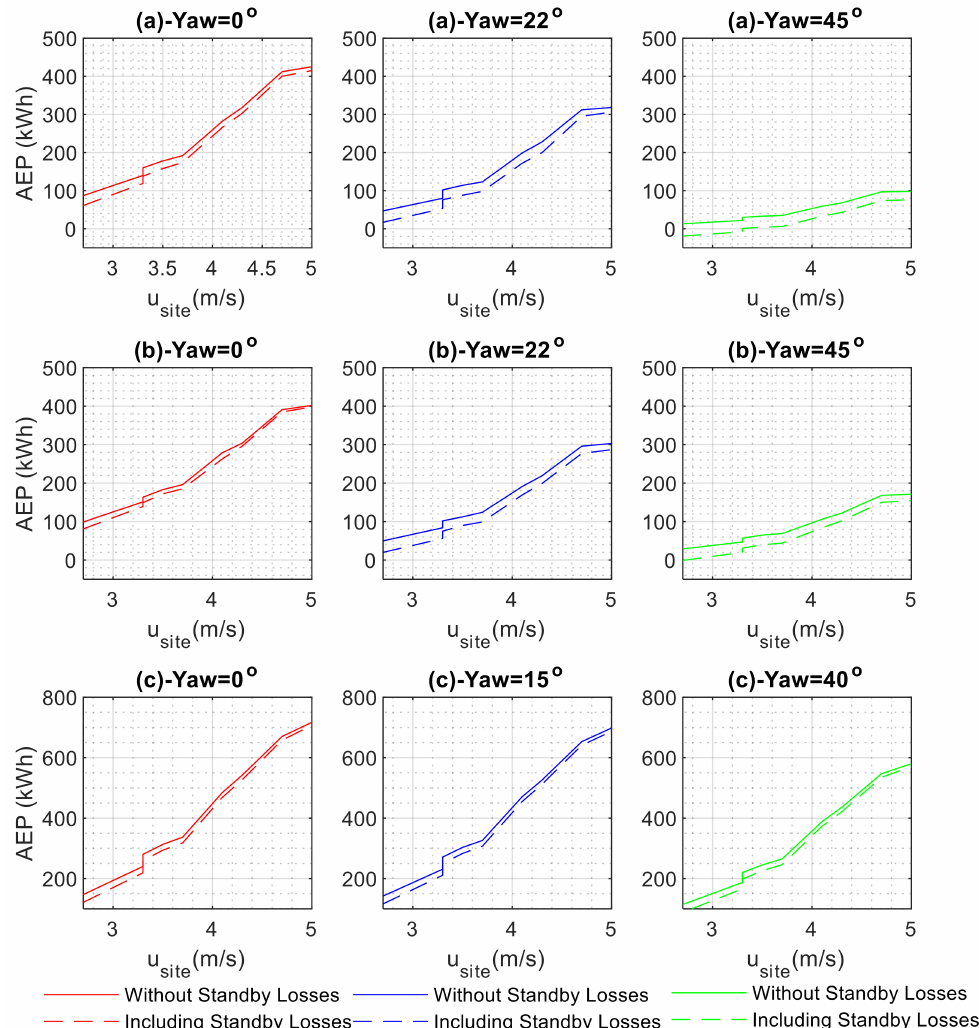
Figure 16. Annual Energy Production AEP (kWh) without and including standby losses for an increasing mean wind speed per different site and different yaw angles for ( a ) 5 bladed upwind, ( b ) 3 bladed downwind, and ( c ) 3 bladed downwind configurations.